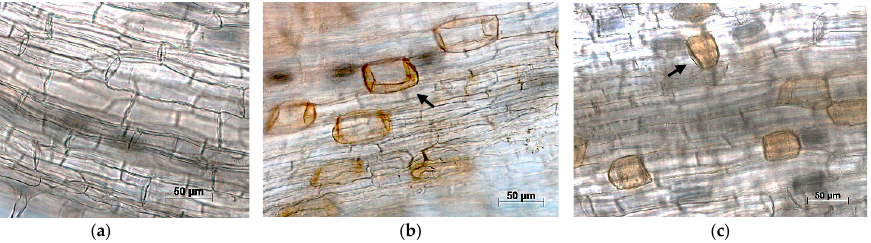
Figure 6. DAB stain of hydrogen peroxide on F. oxysporum -infected roots. Arrows in ( b , c ) mark en- hanced hydrogen peroxide concentration stained by 3,3 Diaminobenzidine ( a ) A. officinalis cv. Thielim 12 hpi; ( b ) A. densiflorus 12 hpi; ( c ) A. aethiopicus 12 hpi.